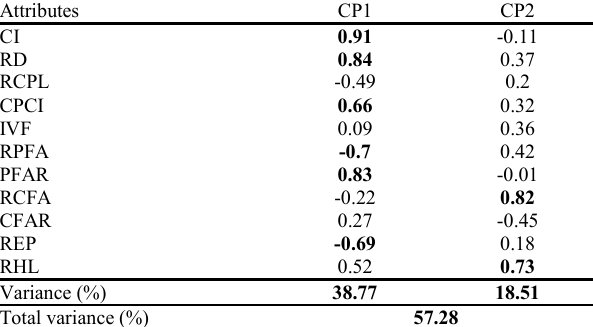
point out that only three species were registered in the headwaters, a richness that could be not enough to allow comparisons based on attributes such as species dispersion in morphological space and distances to the Table 2. Contribution of morphological attributes to the first two PCA axes measured for 67 fish species in the rio das Velhas Basin. Numbers in bold represent scores with higher contribution for the observed variance.